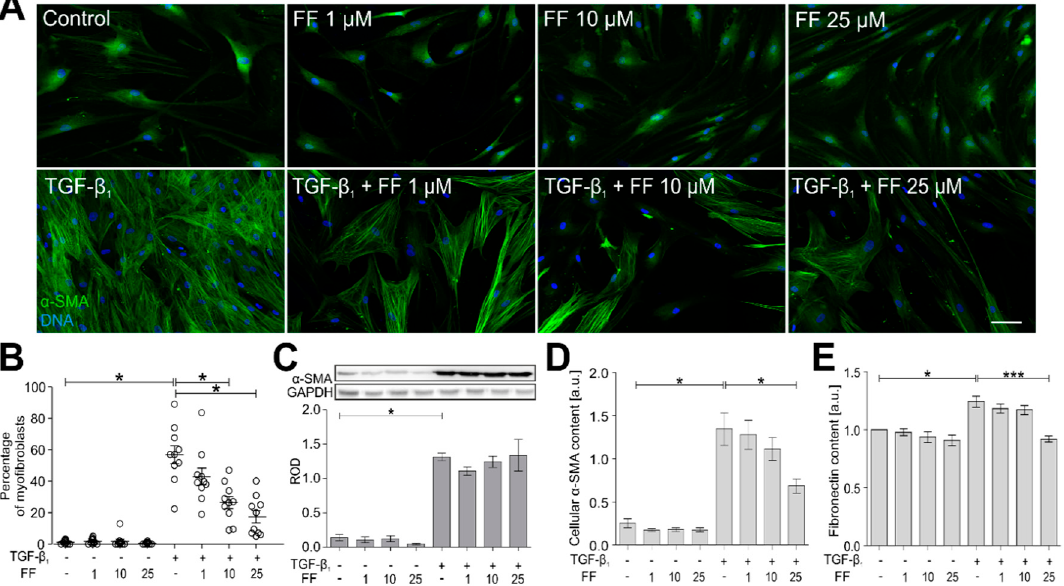
Figure 2. Fenofibrate attenuates the TGF- β 1 -induced phenotypic transition of HBFs into myofibroblasts. ( A ) HBFs were cultured in control conditions or in Dulbecco’s modified Eagle medium (DMEM) supplemented with TGF- β 1 (5 ng/mL) in the absence or presence of FF (1–25 µ M) for seven days. Then, the cells were fixed with 3.7% formaldehyde, permeabilized, and immunostained for α -smooth muscle actin ( α -SMA; green) and DNA (blue) as shown on representative images. Scale bar = 25 µ m. ( B ) The fraction of cells with prominent α -SMA + stress fibers in HBF populations ( n = 10) was determined using fluorescence microscopy in three independent experiments. ( C ) Analyses of α -SMA content were carried out in total cell lysates from HBFs cultured as in ( A ) using immunoblotting. Human glyceraldehyde 3-phosphate dehydrogenase (GAPDH) was used as a loading control. The effect of fenofibrate on the α -SMA levels in the TGF- β 1 -treated HBFs is presented as a bar graph and shows densitometric quantification of Western blots. Data are the mean ± SEM of five independent experiments in triplicate. ( D , E ) α -SMA and fibronectin contents, respectively, were defined using in-cell ELISA, and the results are presented as the mean value of absorbance (450 nm) reflecting the protein content. Data represent the mean ± SEM carried out on HBFs ( n = 10), each in triplicate. Statistical significances were tested using one-way ANOVA with the Bonferroni multiple comparison post hoc test; * p ≤ 0.05, *** p ≤ 0.001. Note that fenofibrate significantly inhibits the formation of α -SMA + stress fibers in the TGF- β 1 -treated HBFs in a dose-dependent manner, and concomitantly, has a slight impact on the total α -SMA